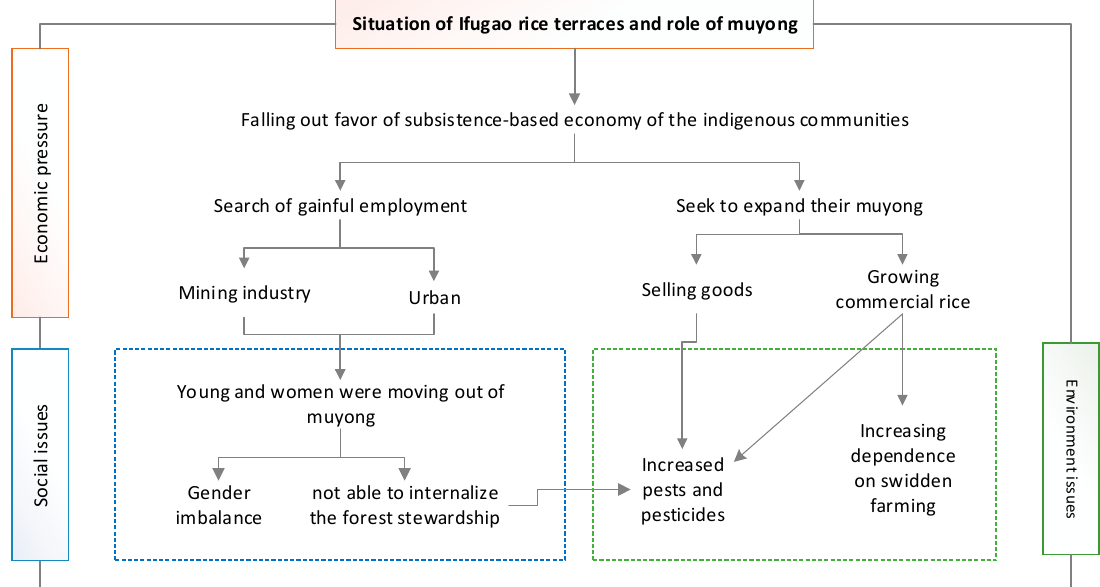
Figure 6. of Economic, environmental and societal issues in the study area.